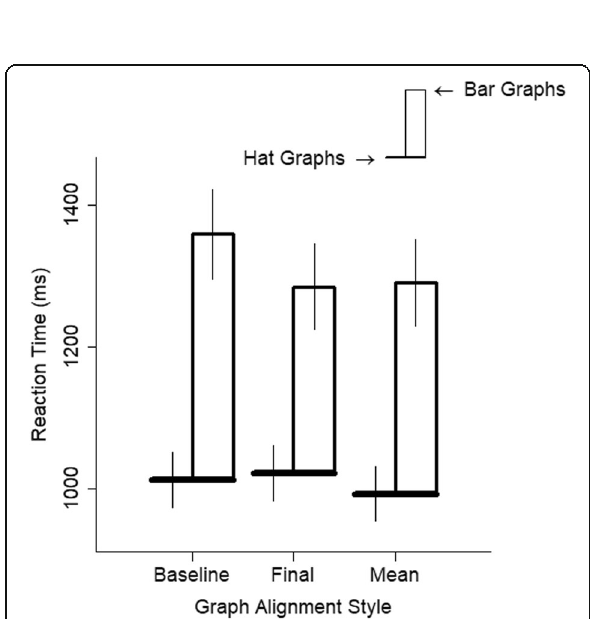
Fig. 6 Reaction time (RT) is plotted as a function of graph alignment style and graph type for experiment 1. The brim of the hat corresponds to the RTs for the hat graph condition, and the top of the crown of the hat corresponds to RTs for the bar graph condition. The size of the crown indicates the difference in RTs between the two conditions. Error bars are ±1 SEM estimated from the mixed linear